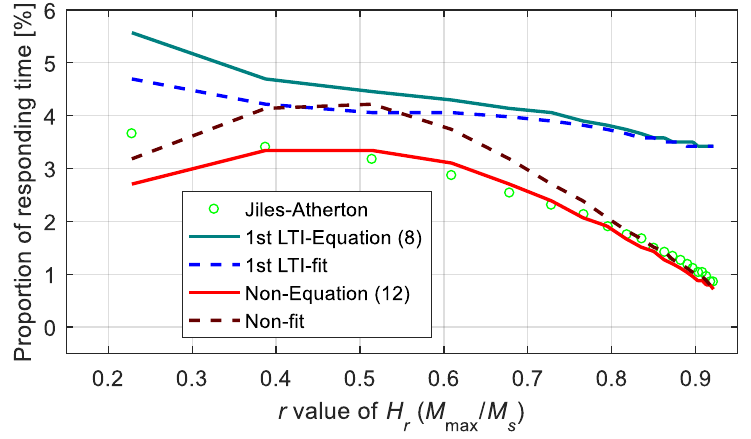
Figure 18. Proportions of the response time calculated from different models.